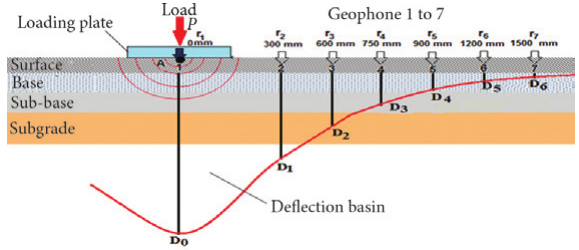
fig. 1. Schematics of a FWD load and deflection measurement